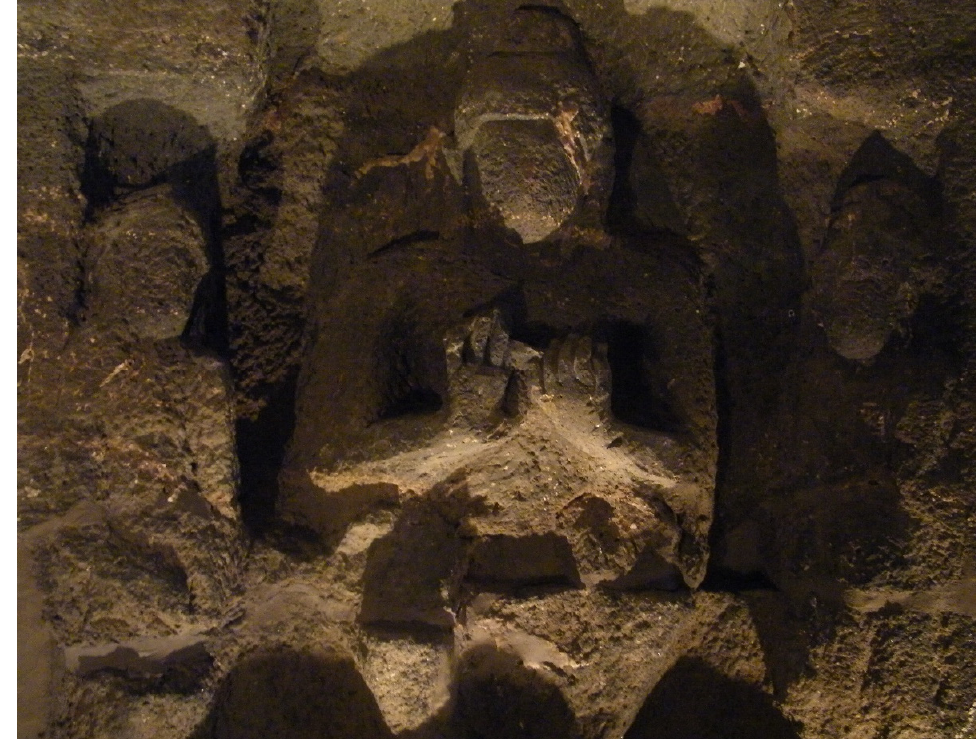
Figure 12. Unfinished intrusive panel from Aja ṇṭ ā Cave 26, circumambulatory wall, ca. 478–480 CE (Photograph by the author).